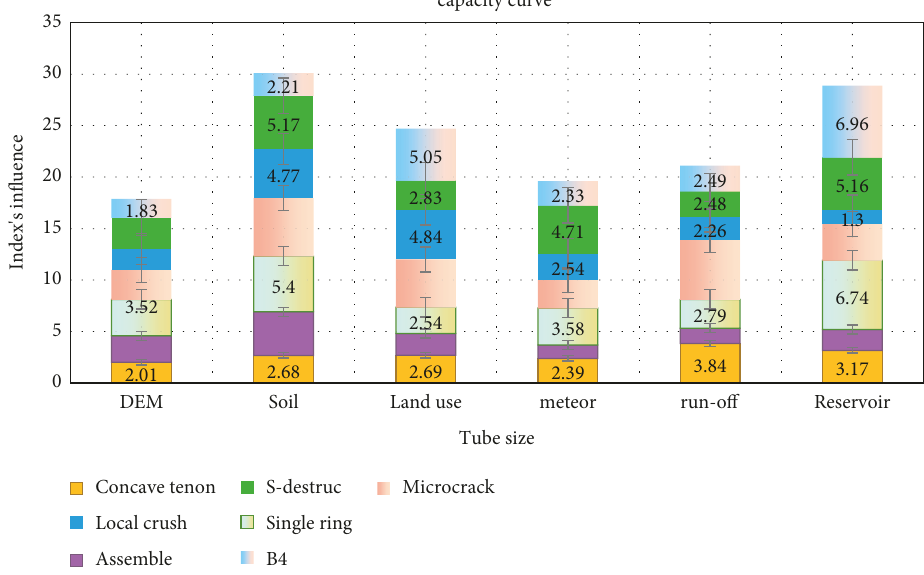
Figure 10: Ultimate bearing capacity curve of the segment and joint ultimate bearing capacity Table 6: The internal force combination of the joint has exceeded its ultimate bearing capacity curve.